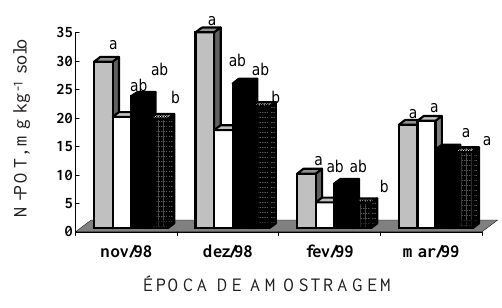
Figura 4. N-amoniacal extraído por solução de (0,005 mol L -1 ) sob autoclavagem em CaCl 2 Latossolo Vermelho distrófico cultivado com laranjeira em diferentes épocas, locais e profundidades de amostragem (PC = linha de projeção da copa, EL = entrelinhas). Letras comparam atividades dentro de cada época de amostragem a 5 % pelo teste de Tukey.